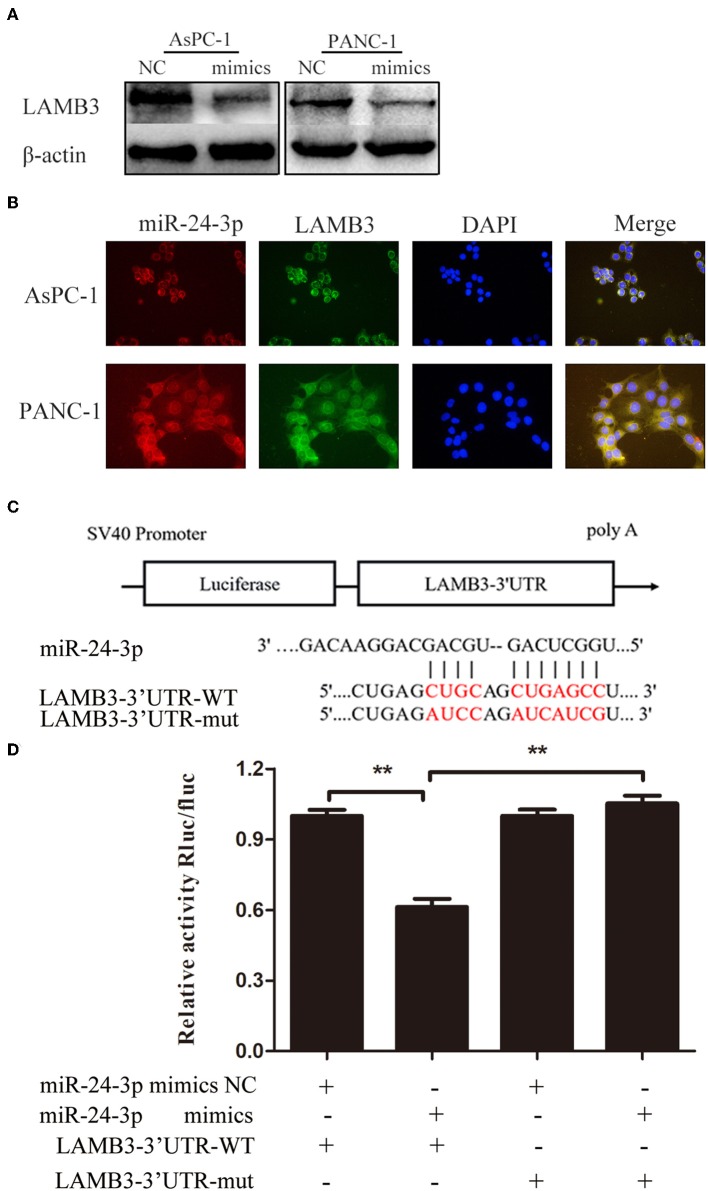
MiR-24-3p targets LAMB3 directly. (A) Western blotting analysis showed that LAMB3 expression was reduced after transfection with miR-24-3p mimics. (B) FISH assay demonstrated that miR-24-3p and LAMB3 mRNA were predominantly localized in the cytoplasm, and co-localization of miR-24-3p and LAMB3 mRNA was observed in PDAC cells. (C) A schematic showing the putative binding sites of miR-24-3p with respect to the 3'UTR of LAMB3. (D) Luciferase assay confirmed that miR-24-3p targeted the 3′UTR region of LAMB3. The data are presented as mean ± SD of three independent experiments. **p < 0.01, Student's t-test.